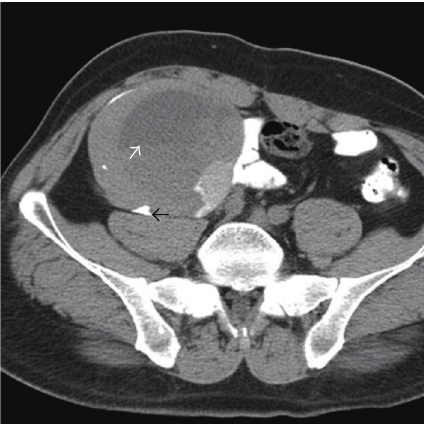
Figure 1: Abdominal precontrast CT shows a thick-walled, cystic, multilocular mass, measuring 10 × 10 cm in front of the right psoas and iliopsoas muscles and adjacent to the iliac vessels. Spotty calcification (black arrow) was seen in the thick, hyperdense wall. White arrow shows fluid-fluid levels.